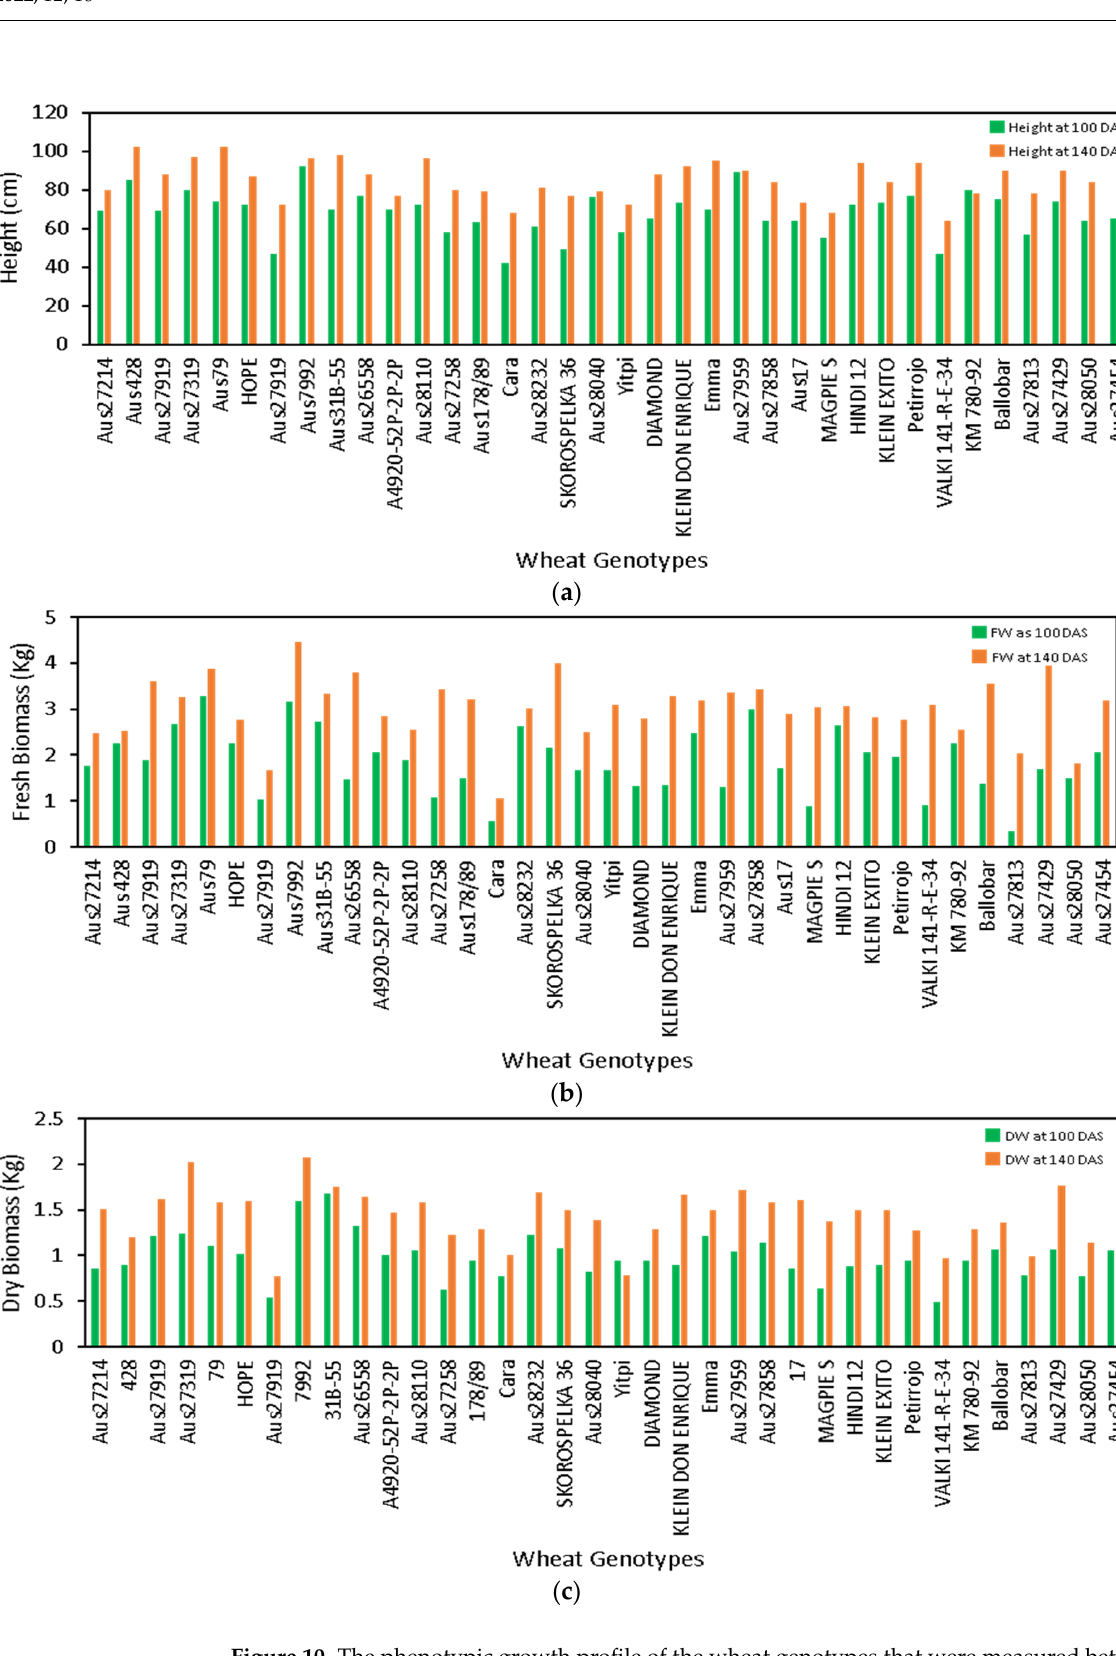
Figure 10. The phenotypic growth profile of the wheat genotypes that were measured between two time points—100 and 140 DAS. ( a ) plant height, ( b ) fresh weight, and ( c ) dry weight. The pheno- typic growth profiles that were measured using the CBM sensor aid in the genotypic screening of wheat